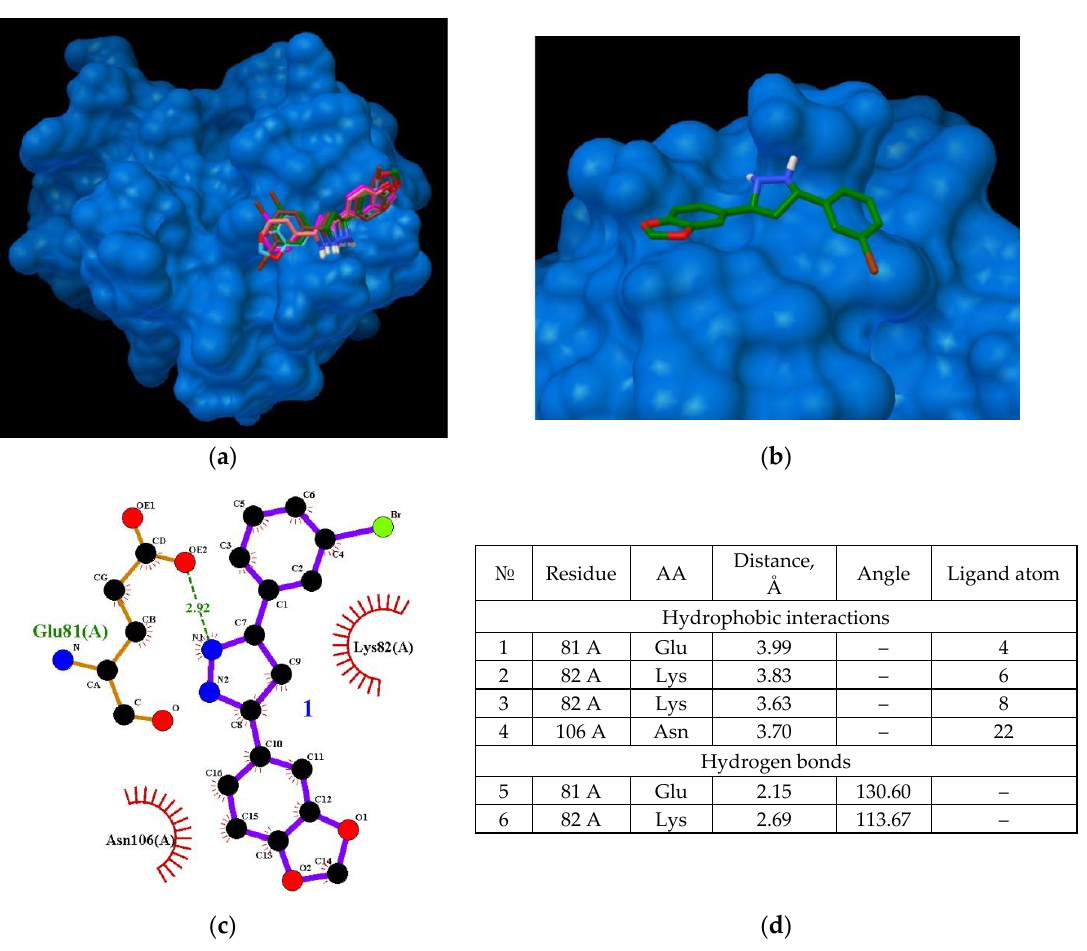
Figure 4. Binding of the Anle138b molecule to CypA (a cellular partner protein of alpha-synuclein) ( a ) full size image; ( b ) an enlarged image of a possible CypA binding site; ( c ) interactions diagram of Anle138b with cyclophilin; ( d ) interaction options for Anle138b binding to CypA.